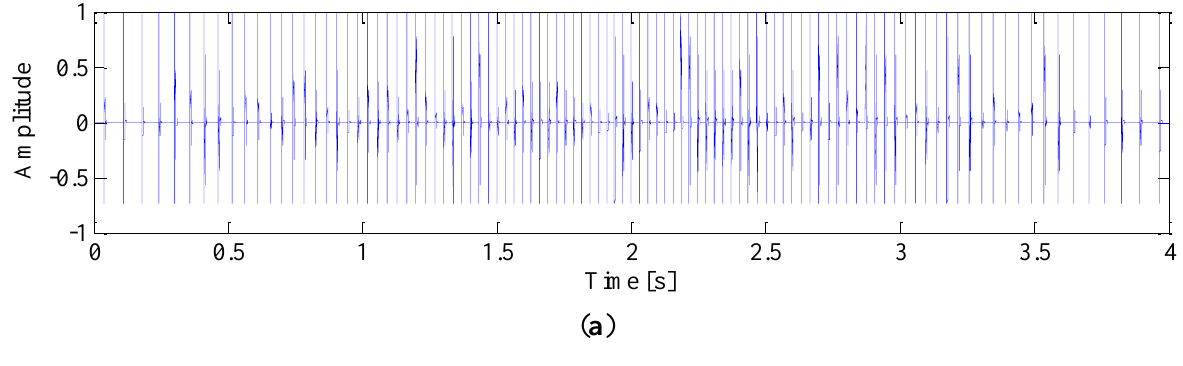
Figure 3. Simulated signal: ( a ) Impulse signal; ( b ) Harmonics of shaft; ( c ) Noise signal; ( d ) Mixed